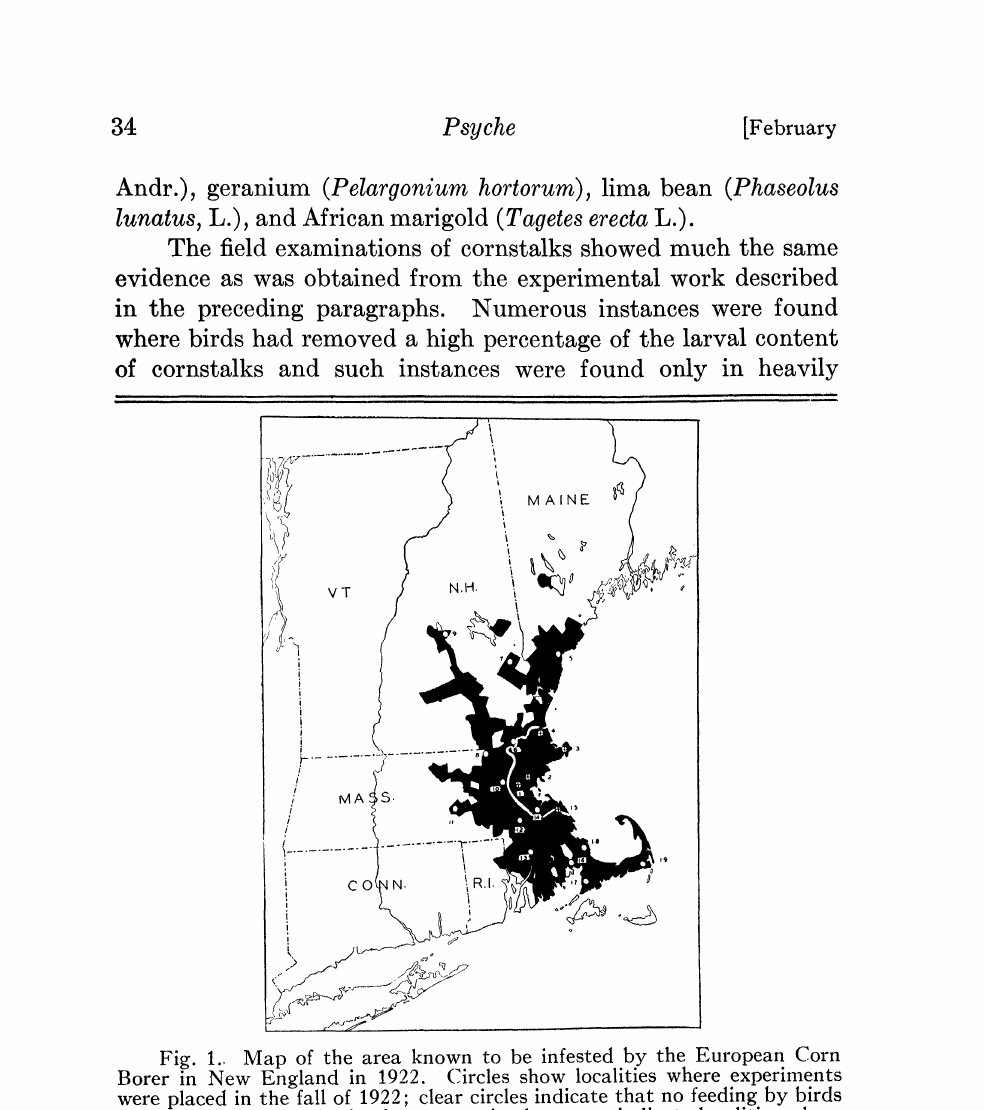
Fig. 1.. Map of the area known to be infested by the European Corn Borer in New England in 1922. Circles show localities where experiments were placed in the fall of 1922; clear circles indicate that no feeding by birds was found, while circles having a cross in the center indicate localities where birds fed on larvae contained in the corn stalks of the experiment. A white line surrounds the area known to be infested up to July 1, 1919. 1--Arlington,